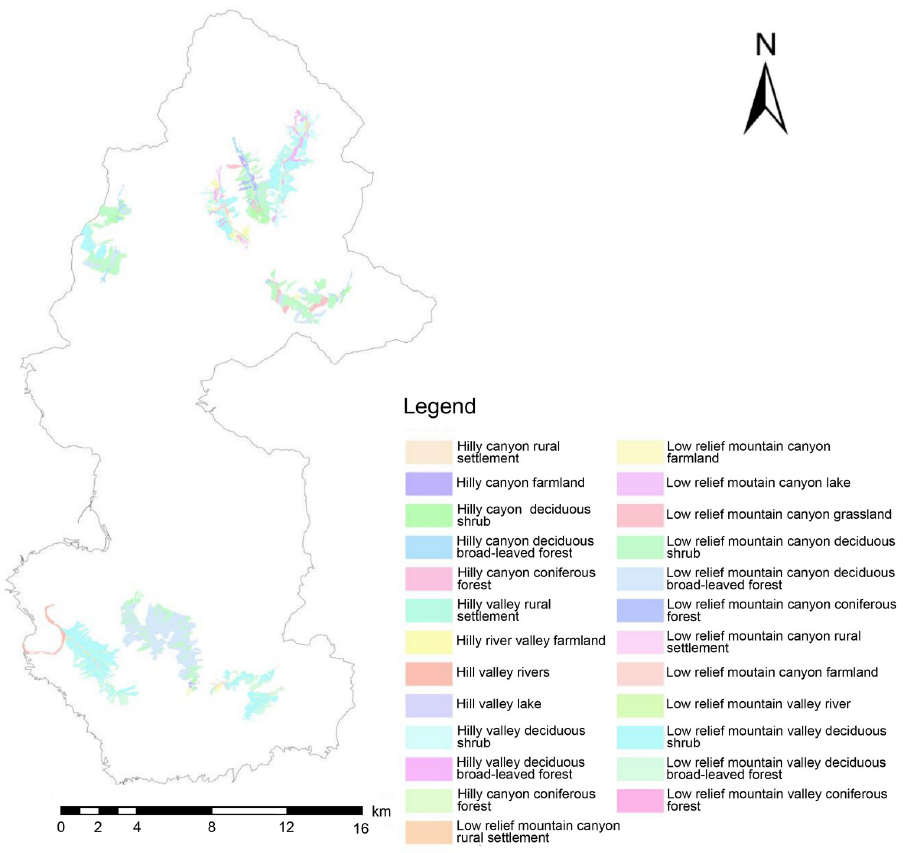
Fig 4. Distribution map of scenic resource groups in canyon/river valley areas. (Republished from [https:// directory.eoportal.org/web/eoportal/satellite-missions/g/gaofen-2] under a CC BY license, with permission